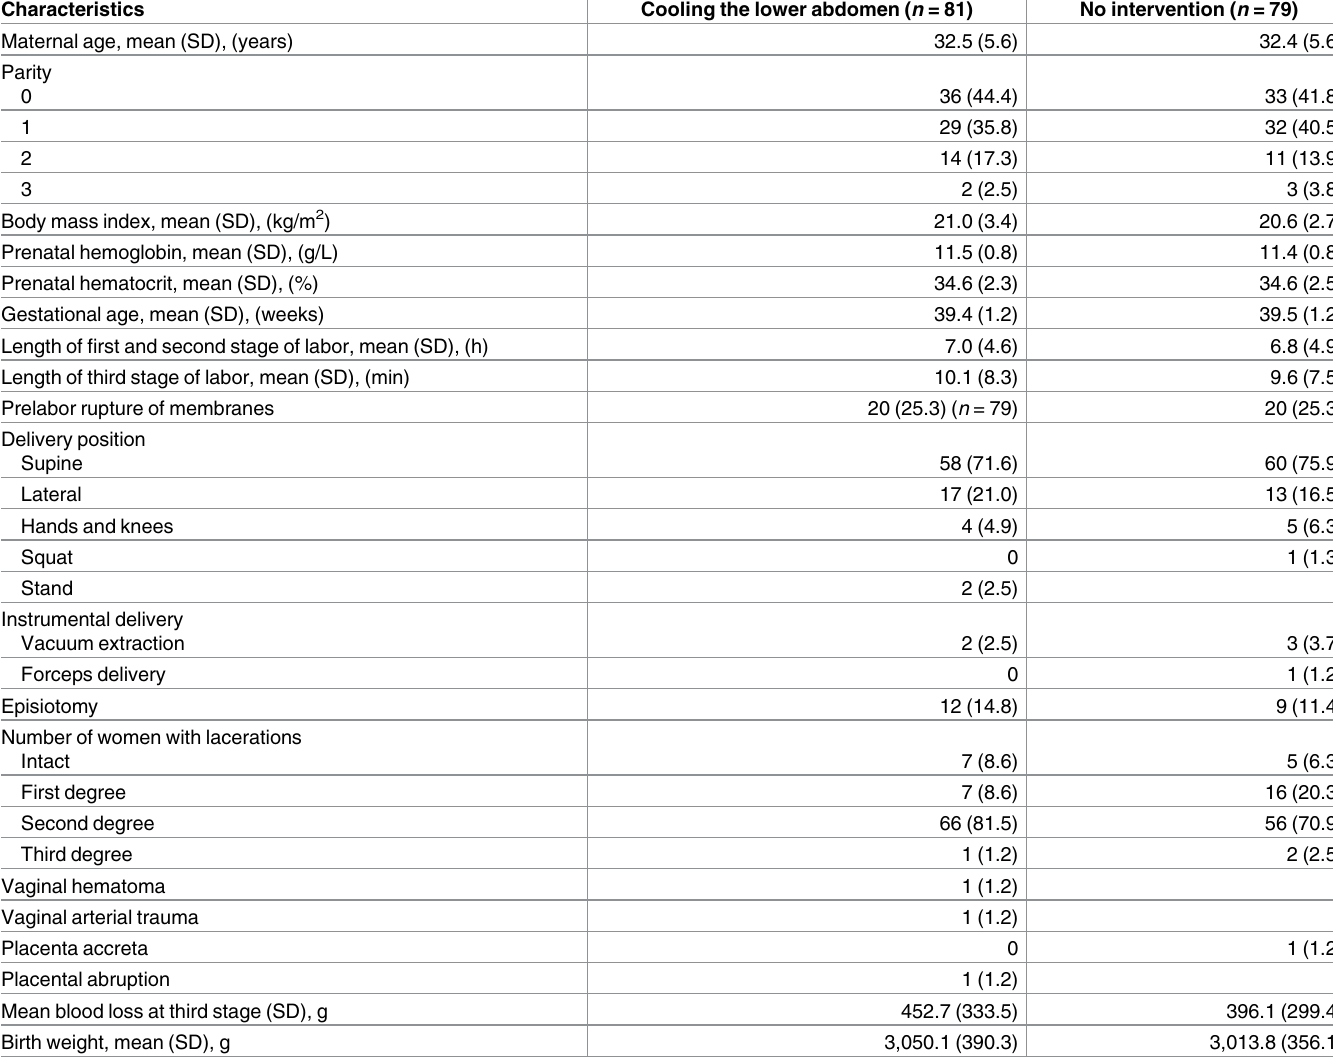
Table 1. Baseline characteristics of the study participants. Valuesare numbers (percentages) of